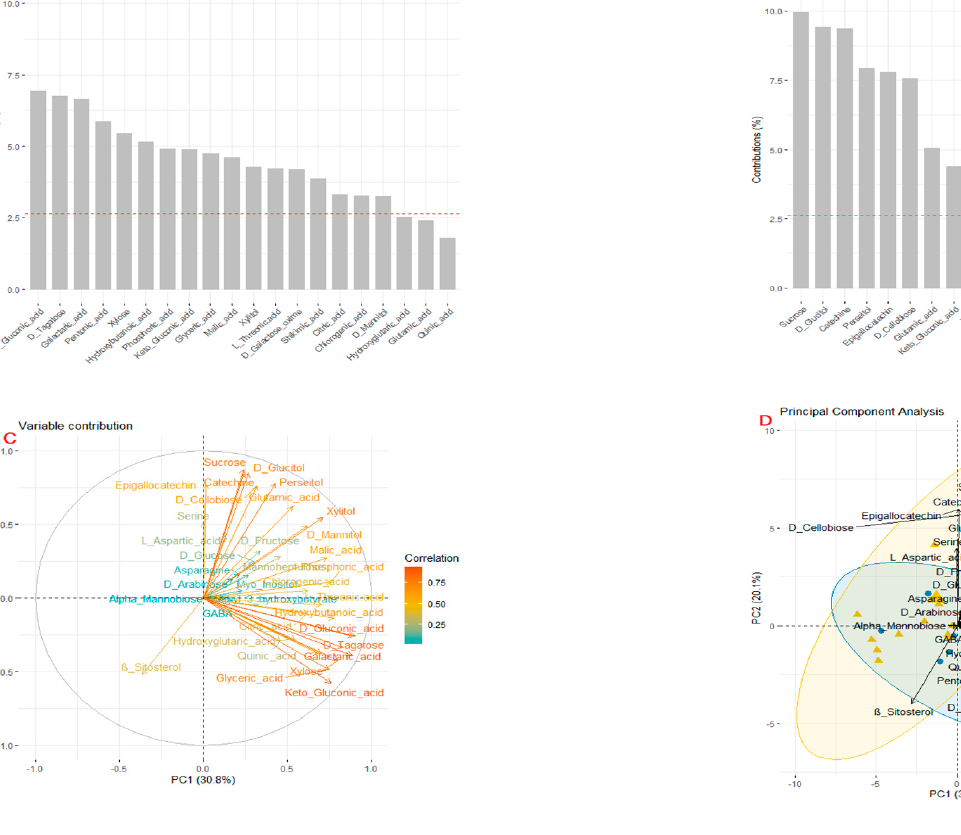
Figure 1. ( A – D ): Variable contribution to PC1 and PC2 ( A , B ), the loadings ( C ), and principal component analysis biplot of polar metabolites ( D ).